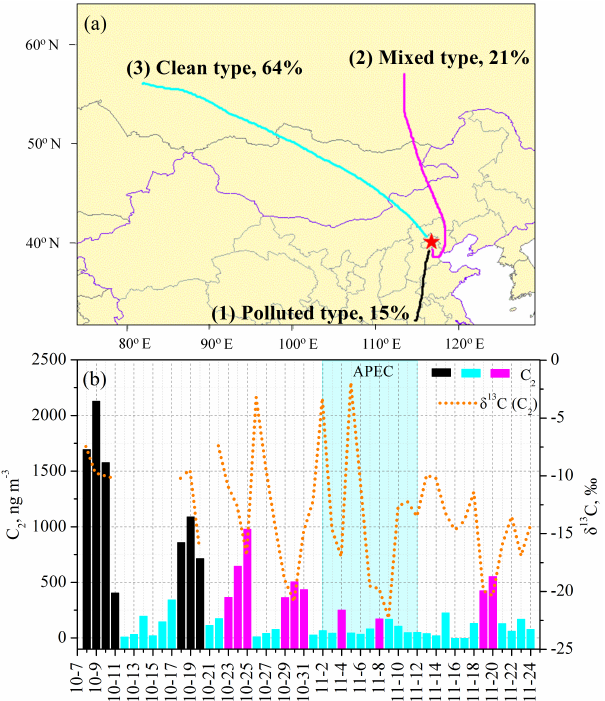
Figure 6. (a) 72h backward trajectories determined by the National Oceanic and Atmospheric Administration Hybrid Single Particle Lagrangian Integrated Trajectory (HYSPLIT) model arriving at the sampling site to reveal the major air-mass flow types during the study period. Northwesterly wind (light blue) was most frequent (64%), followed by northerly (21%, pink) and southerly (15%, black), and these are defined as clean, mixed, and polluted types, respectively (see the definitions in the text and the trajectories with a 6h interval in the Supplement); (b) time series of δ 13 C values and concentration of oxalic acid during the whole study period (colors in Fig. 6a are corresponding to those in Fig.